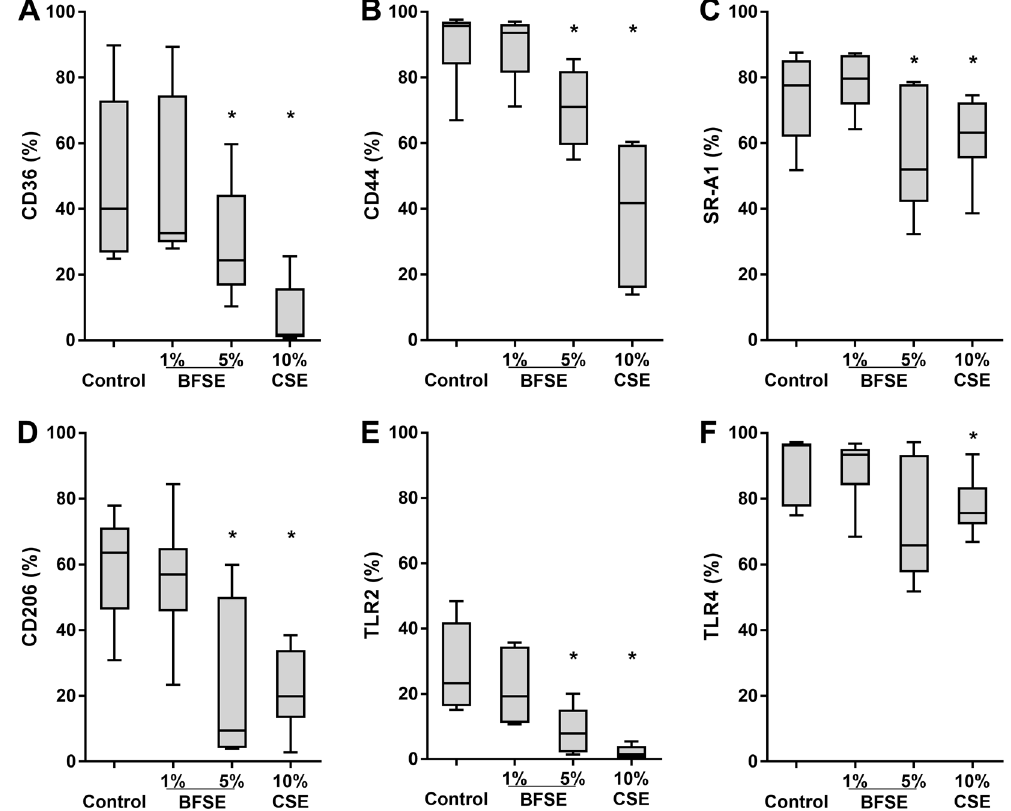
Figure 2. BFSE alters phagocytic recognition receptors. MDM were exposure to air control, 1% or 5% BFSE or 10% CSE for 24 h. Cell surface markers: CD36 ( A ), CD44 ( B ), SR-A1 ( C ), CD206 ( D ), TLR-2 ( E ) and TLR-4 ( F ) were detected by immunofluorescence on a FACScanto II flow cytometer and expressed as % positive cells compared to negative controls. (n = 5) * p <